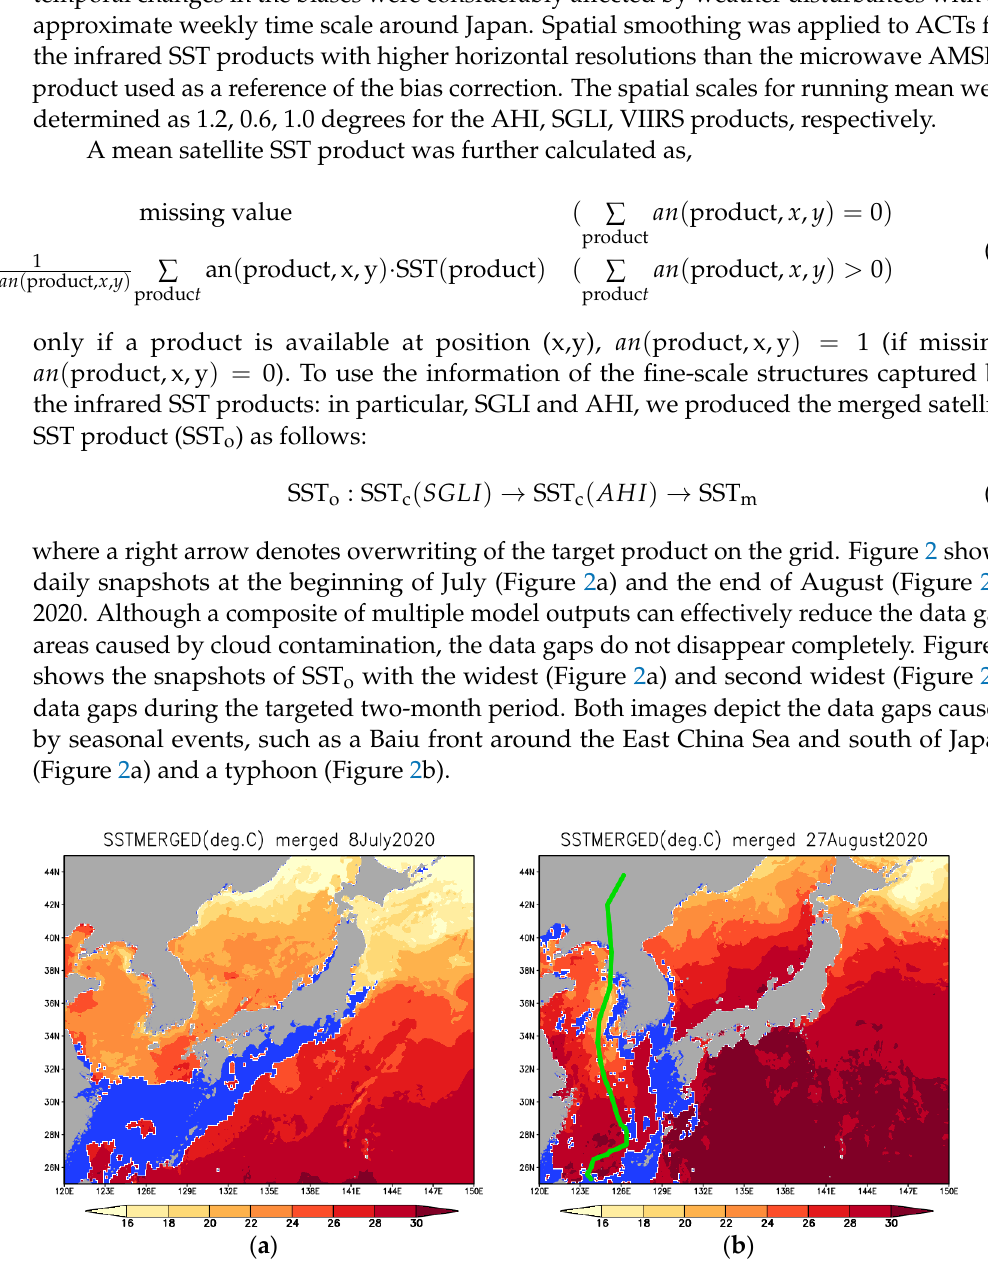
Figure 2. Daily composite of the merged satellite SST (in °C). Data gaps are represented by blue shading. ( a ) 8 July 2020, ( b ) 27 August 2020. The track of the typhoon (BAVI) number 8, 2020 is depicted by a green color curve in ( b ).